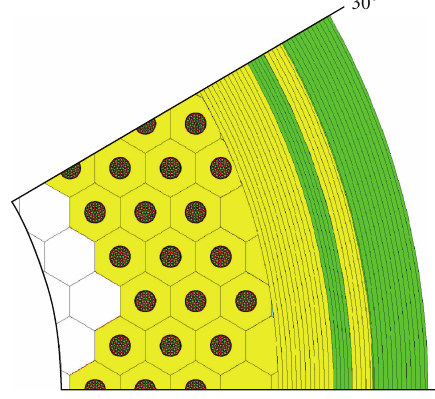
Figure 6: Scheme 1/24 of the reactor.